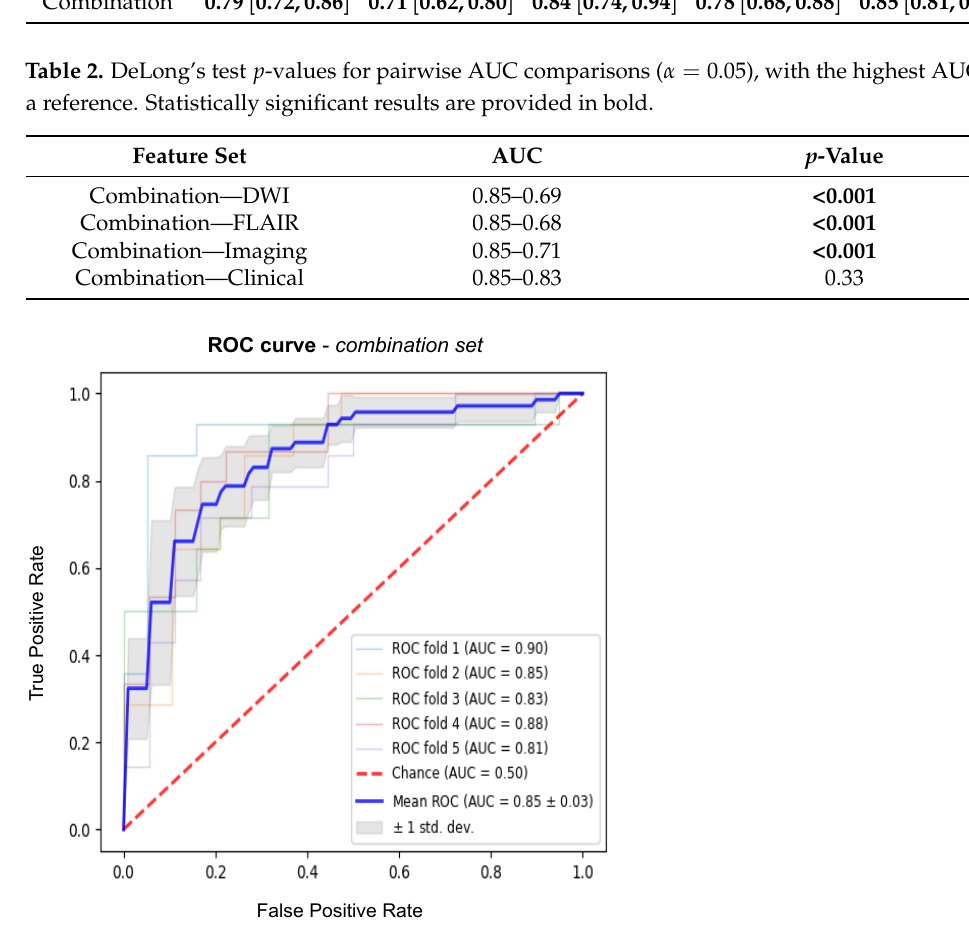
Figure 6. Average ROC curve (blue) obtained from the outer cross-validation of the best-performing model ( combination set